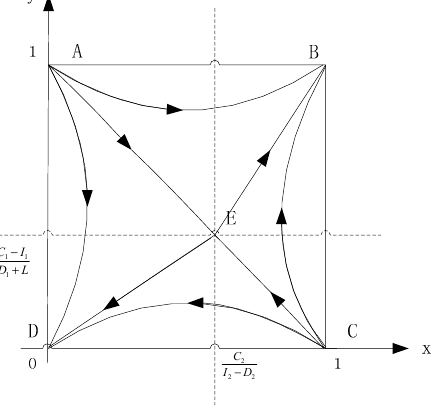
Figure 2. Evolutionary phase diagram of Internet finance government audit supervision game.